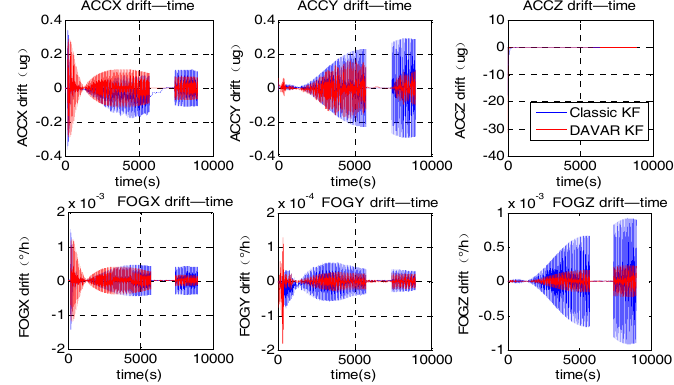
Figure 6. Estimate of FOGs drifts and Accelerometers drifts.